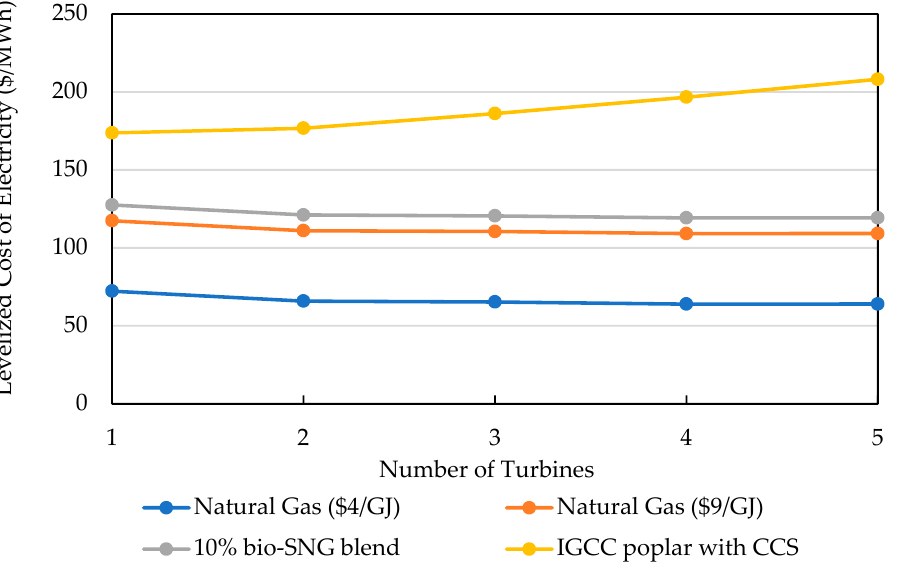
Figure 10. Predicted LCOE for NGCC power plants co-fired with upgraded syngas produced from poplar.